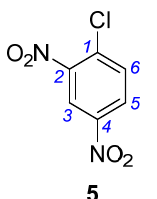
Figure 2. 2,4-Dinitrochlorobenzene ( 5 ).